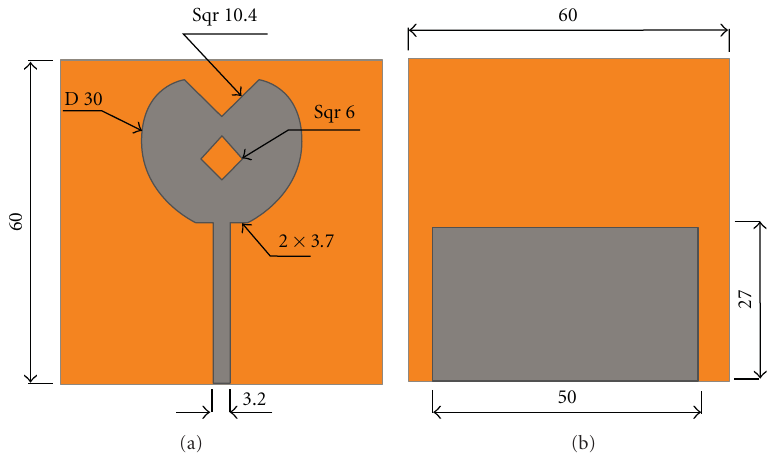
Figure 1: CST model along with the geometry and dimensions in millimetre of the current paper design; (a) front view and (b) back view of the proposed antenna design.